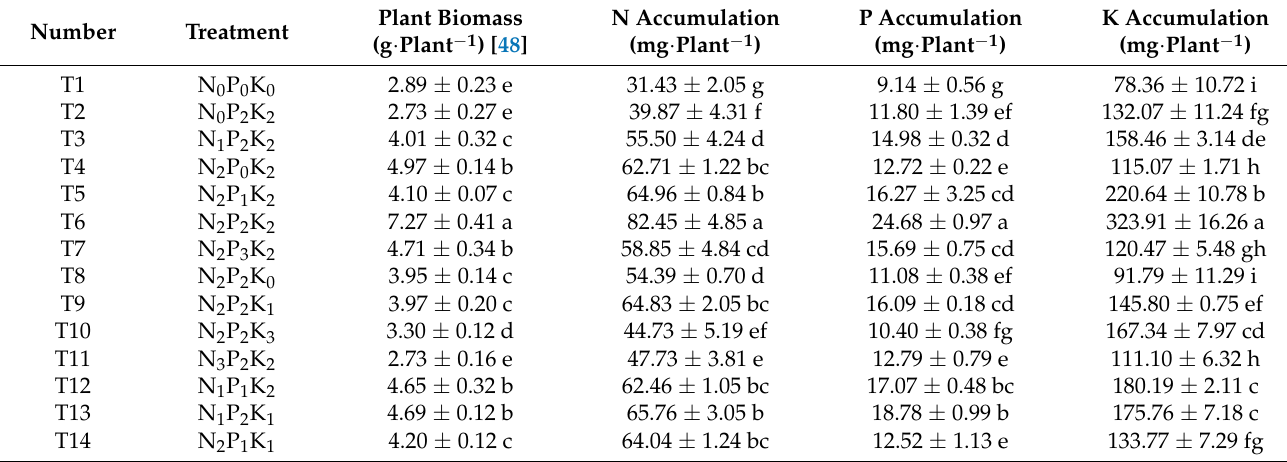
Means ± SD with different letters indicate a significant difference among the 14 treatments, as determined by Duncan’s multiple range test ( p < 0.05). Data from Yang et al., 2020